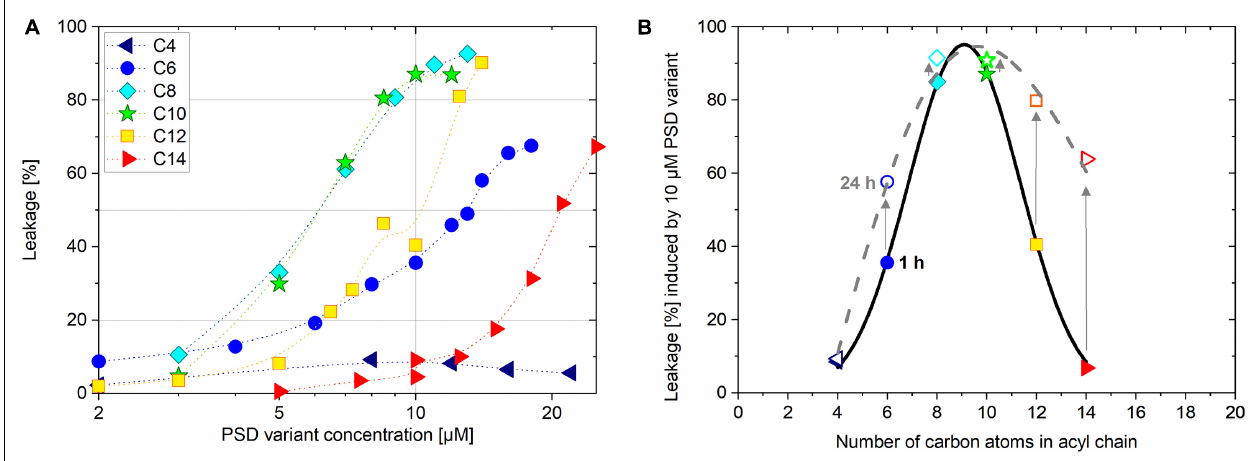
FIGURE 3 | Induced leakage of 30 µ M calcein-LUV after 1 h incubation time as a function of PSD concentration (A) . Leakage of 30 µ M calcein-LUV induced by 10 µ M PSD as a function of PSD acyl chain length after 1 h (filled symbols) and 24 h (open symbols) incubation time (B) . TABLE 1 | Effective PSD concentrations to induce 20, 50, and 80% calcein leakage of 30 µ M calcein-LUVs after 1 and 24 h incubation time. PSD 1 h incubation 24 h